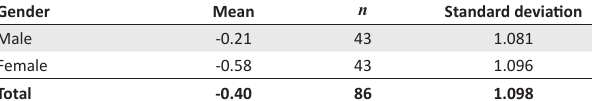
TABLE 12: Changes in disaster loss by gender (mean scores).